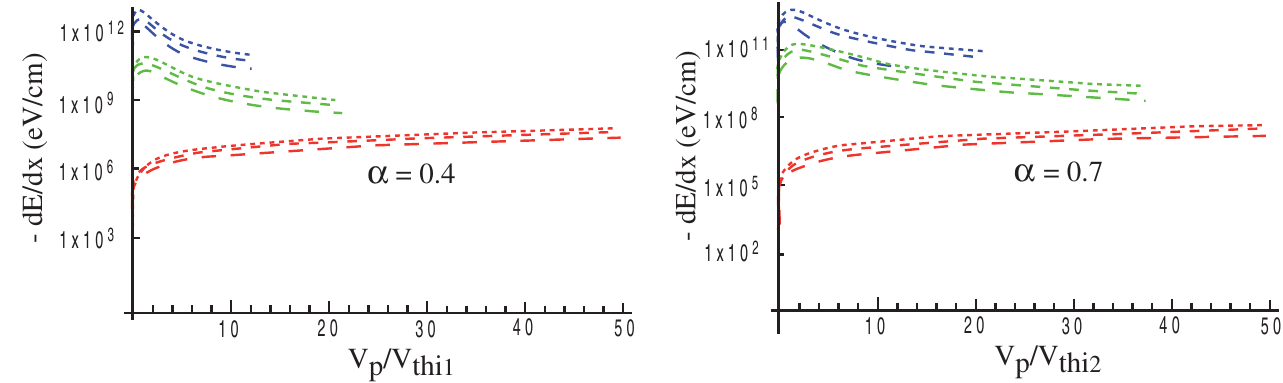
FIG. 7. (Color) Proton (cid:1) dE=dx ( eV = cm ) with respect to V p =V thi in a He 2 þ - C 6 þ BIM at n e ¼ 10 26 e cm (cid:1) 3 with T ð keV Þ ¼ ( ) 1, ( ) 2, and ( ) 5. (cid:1) ¼ He 2 þ concentration. Dark gray (red) denotes e stopping, light gray (green) pertains to He 2 þ stopping, and black (blue) to C 6 þ the very low V p =V thi considered range, electron contribu- Fig. 8 for (cid:1) ¼ 0 : 5 . As above, the electron LVISD does not show up on these very low velocity linear scales, while the tion has vanished and the Si 14 one should be quantitatively He 2 þ contribution hardly appears when V included only for (cid:1) ¼ 0 : 9 and V p =V th2 (cid:5) 4 . It should be p is scaled by V thi2 . Turning to Si 14 þ - Sn 36 BIM immersed also in a dense plasma impacting (cid:1) particles and advocated n e ð cm (cid:1) 3 Þ ¼ 10 26 and T ð keV Þ ¼ 100 and 200, with pertaining to LVISD pictured on Figs. 9 with linear (cid:1) dE=dx ð eV = cm Þ . Within